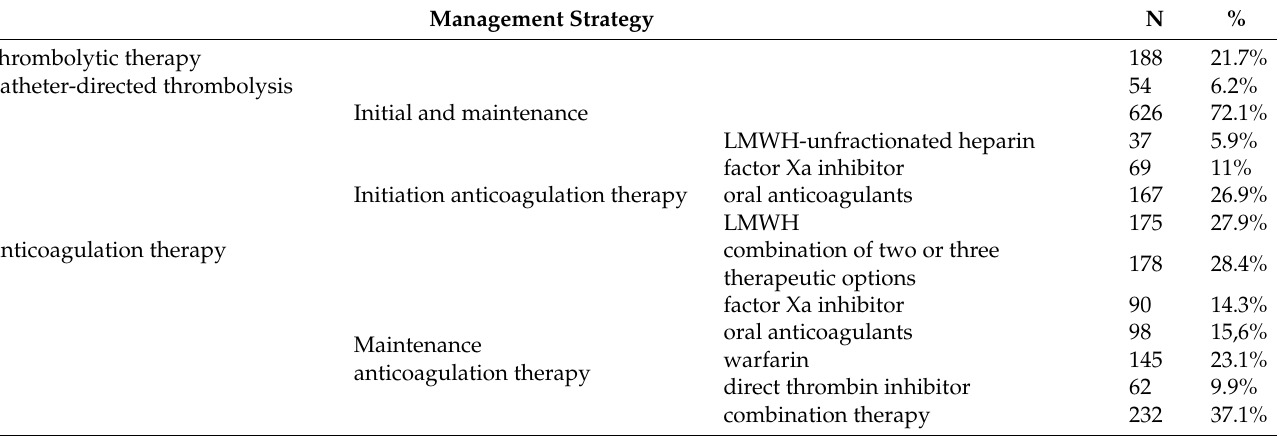
Table 3. The management strategies used for VTE in Saudi patients.